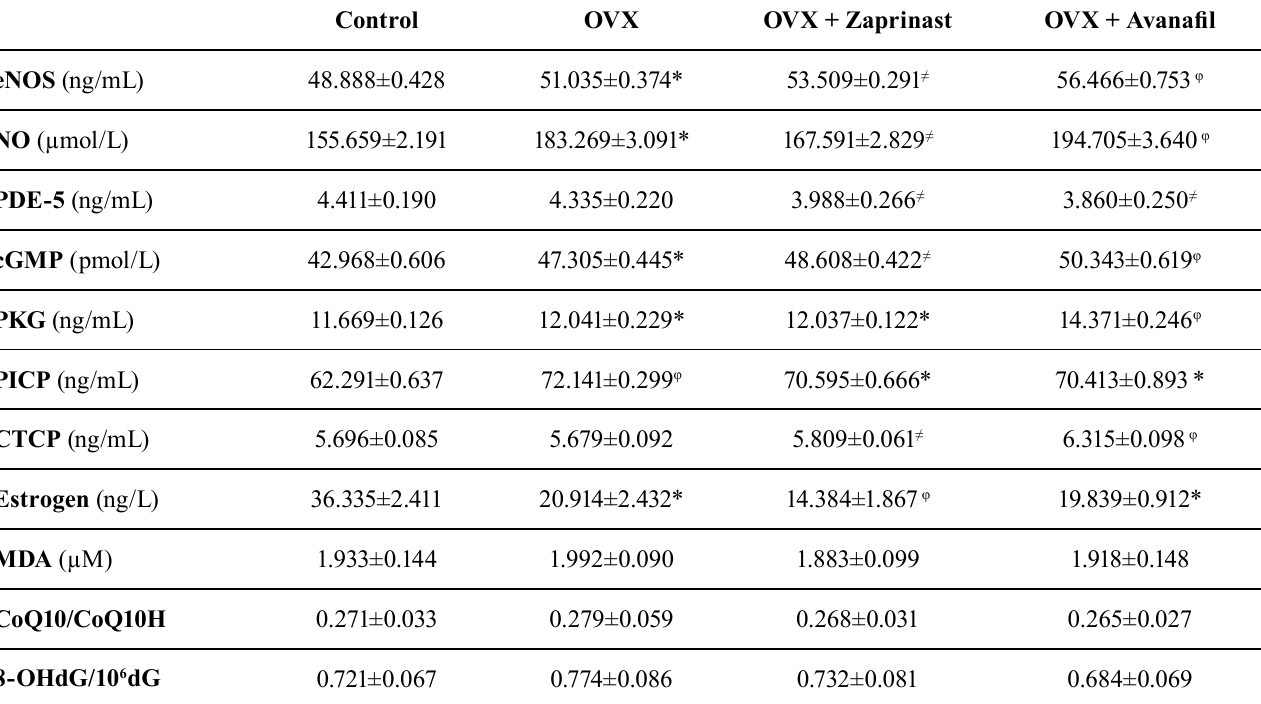
TABLE I – C omparison of the plasma levels of intermediates in the NO signaling pathway, selected bone formation and degradation markers, cortisol and selected oxidative stress parameter values in rats with ovariectomy-induced